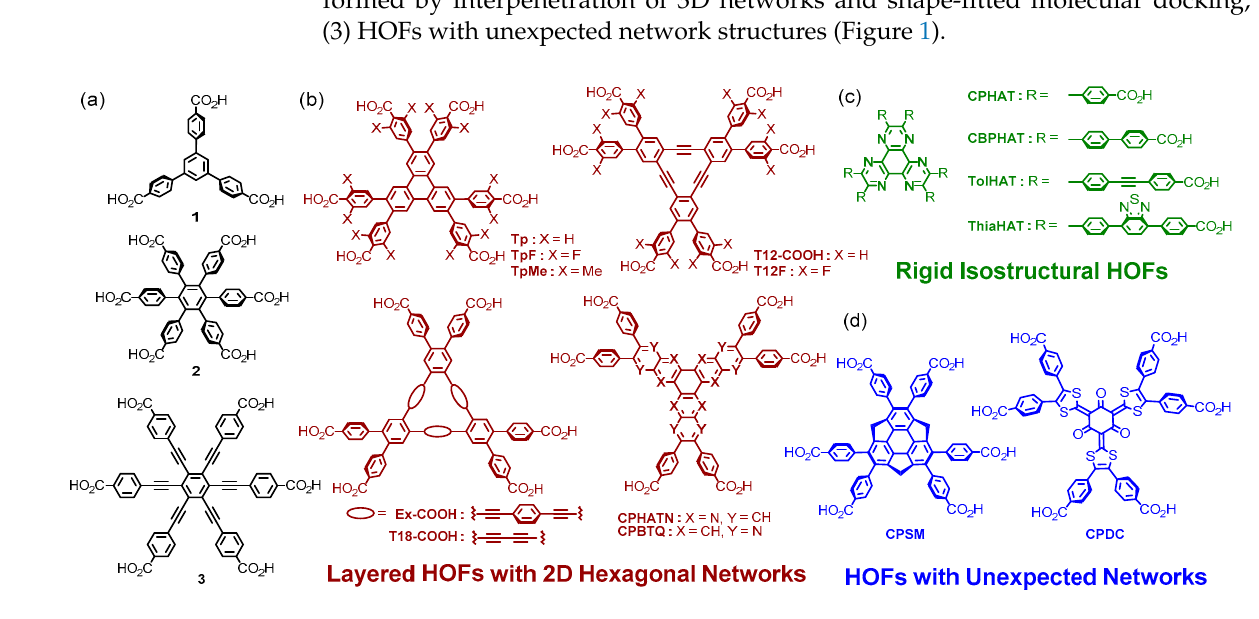
Figure 1. Examples of carboxylic acids for HOFs construction: ( a ) tri- and hexa-substituted benzene derivatives; ( b ) C 3 -symmetric π -conjugated molecules ( C 3 PIs) providing layered HOFs; ( c ) C 3 PIs providing 3D-networked rigid HOFs; ( d ) C 3 PIs providing HOFs with unexpected H-bonded networks. The methyl ester derivatives corresponding to the carboxylic acids are denoted by the postfixed -COOMe (e.g., the ester derivative of T12-COOH is described as T12-COOMe).